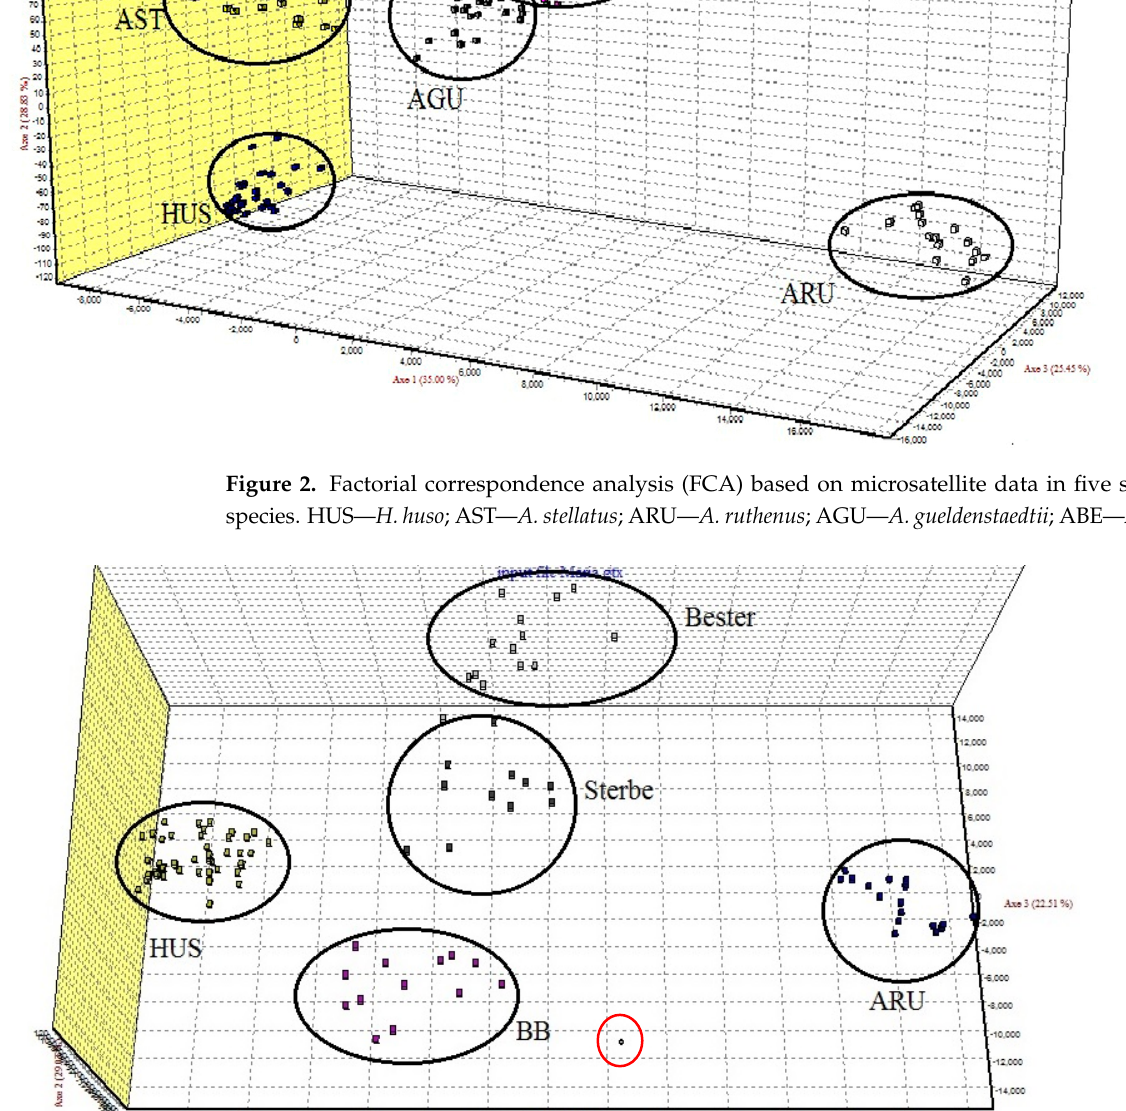
Figure 3. Factorial correspondence analysis (FCA) based on microsatellite data in two sturgeon species and their interspecies hybrids. HUS— H. huso ; ARU— A. ruthenus ; BB—best beluga.